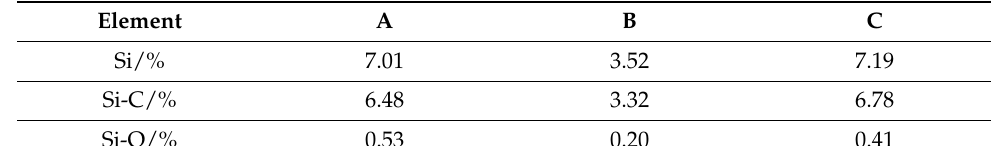
Table 1. Surface silicon content of EP-POSS after adding inorganic nanoparticles. ( A ) EP-